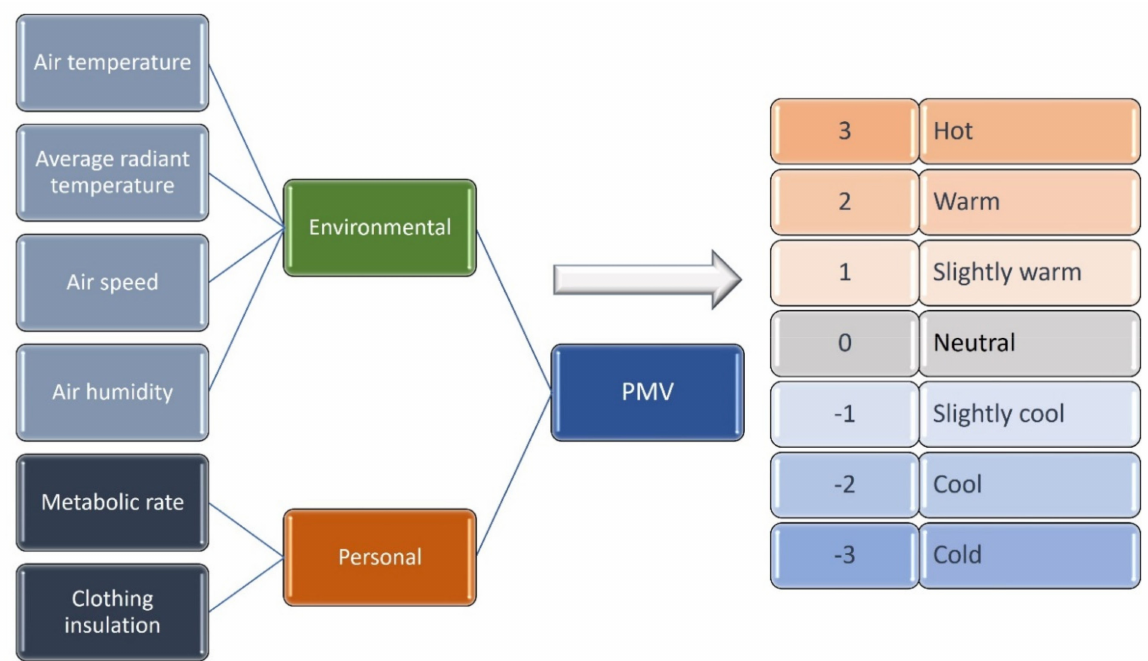
Figure 2. Parameters used in the predicted mean vote (PMV) calculation and relation to thermal sensation